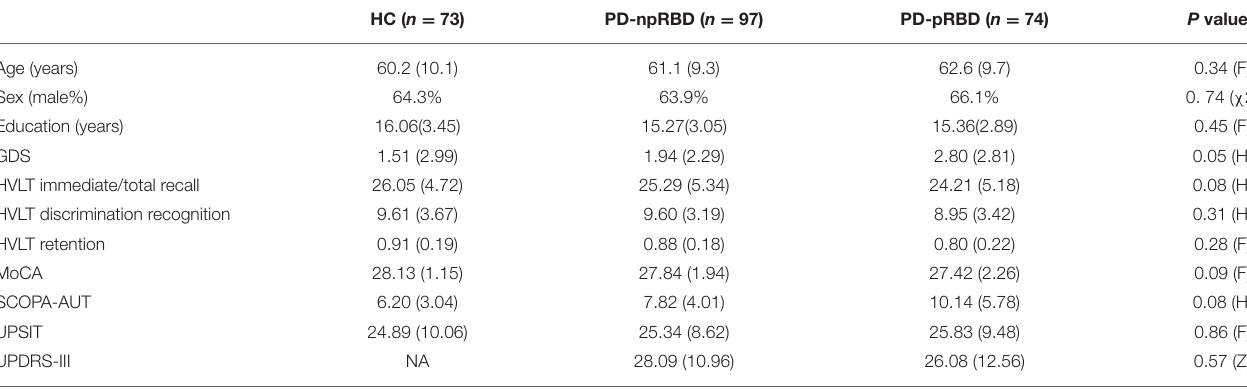
TABLE 1 | Demographic and clinical characteristics of HC, PD-npRBD and PD-pRBD patients.